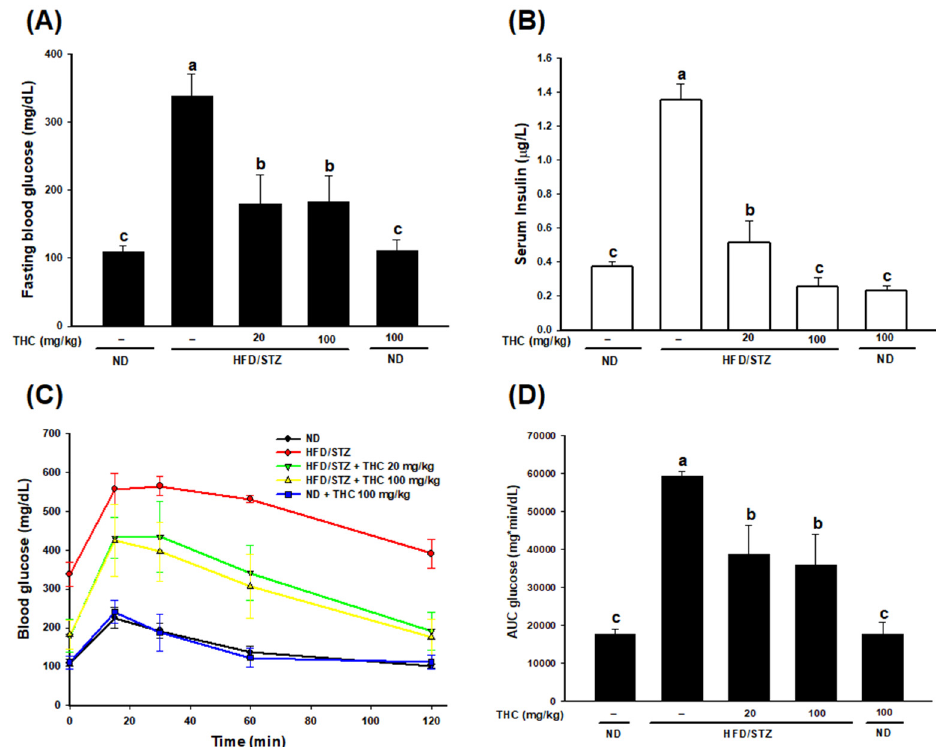
Figure 1. THC intervention reduces HFD/STZ-induced impaired glucose homeostasis and hyperinsulinemia. ( A ) Fasting blood glucose. ( B ) Fasting serum insulin levels. ( C ) Blood glucose during an OGTT and ( D ) corresponding AUC. Data are presented as mean ± SEM ( n = 5–6). Statistical differences ( p < 0.05) between groups were evaluated by one-way ANOVA with Tukey’s post-hoc test and were labeled as different letters (a, b, and c). AUC: areas under the curve; HFD/STZ: high fat diet/ streptozotocin; ND: normal diet; OGTT, oral glucose tolerance test; THC: